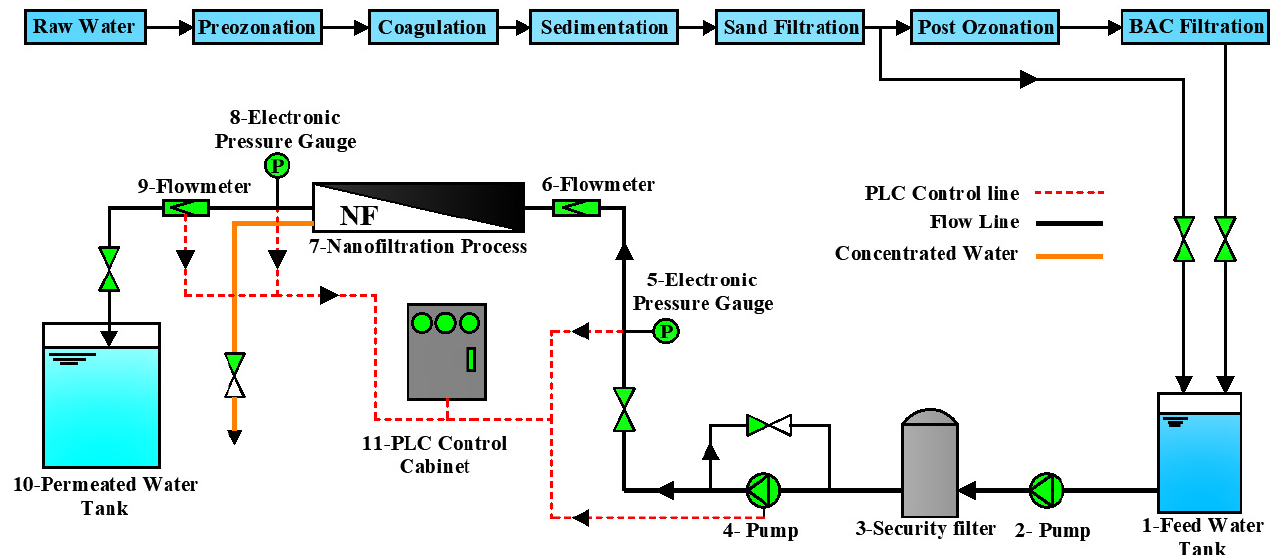
Figure 1. A schematic diagram of the pilot-plant system.